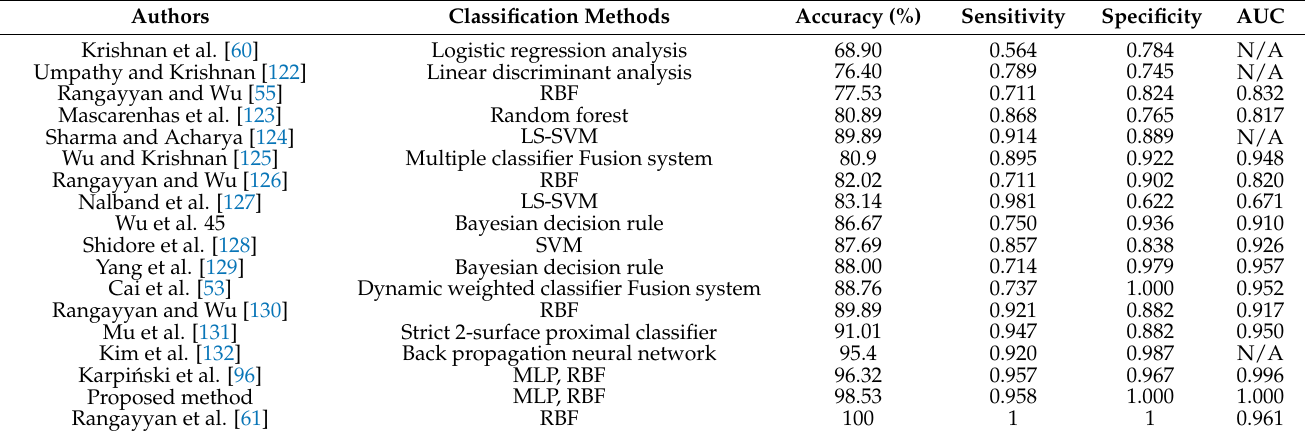
Table 6. Comparison diagnostic results of proposed method with other related